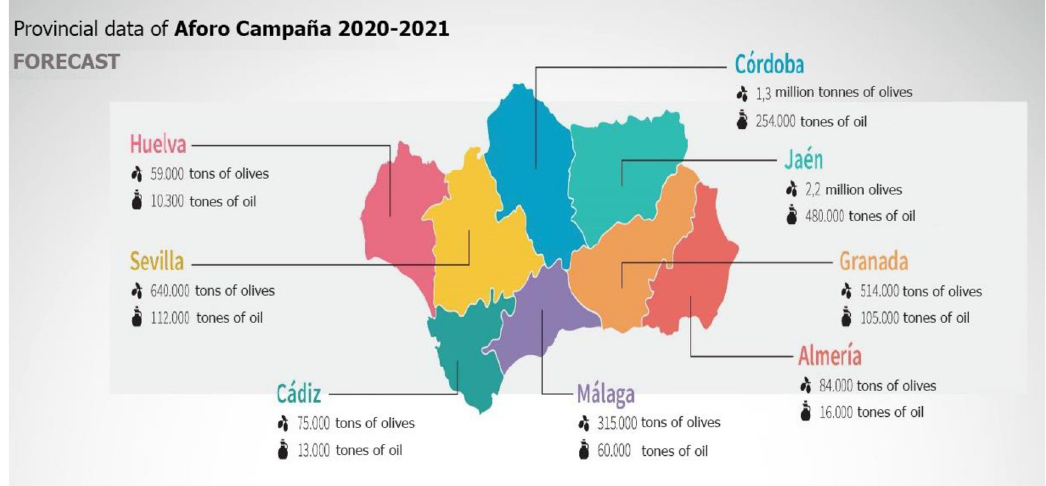
Fig 1. Olive cultivation area and oil production in Andalusia (2021–22 season). Source: Prepared by the authors based on information from the Agricultural and Fisheries Agency (Junta de Andalucı´a).